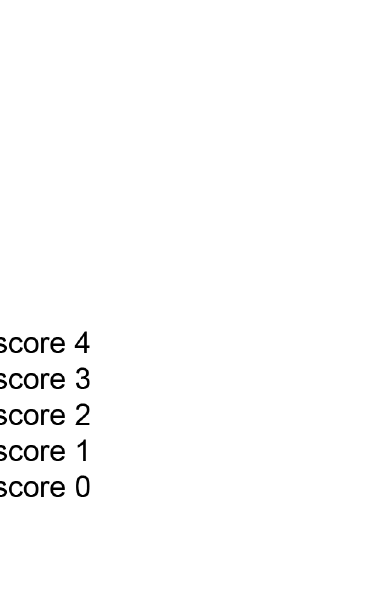
Fig 2. Apfel scores. Relative frequency of patients with Apfel scores 0 – 4 in the haloperidol group and in the non-haloperidol